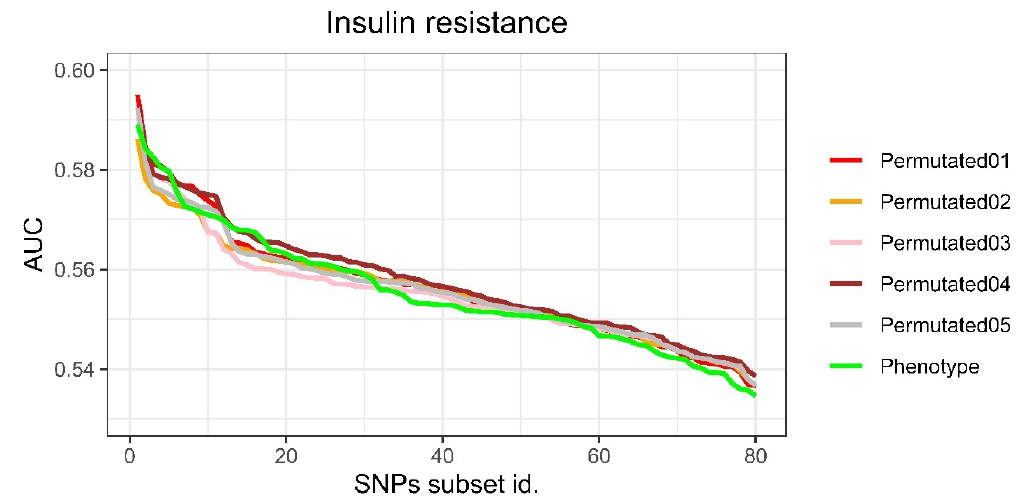
Figure 4. AUC values of the 80 iterations performed for the insulin resistance pathway in the case of cases and controls (phenotype) and five different permutations.